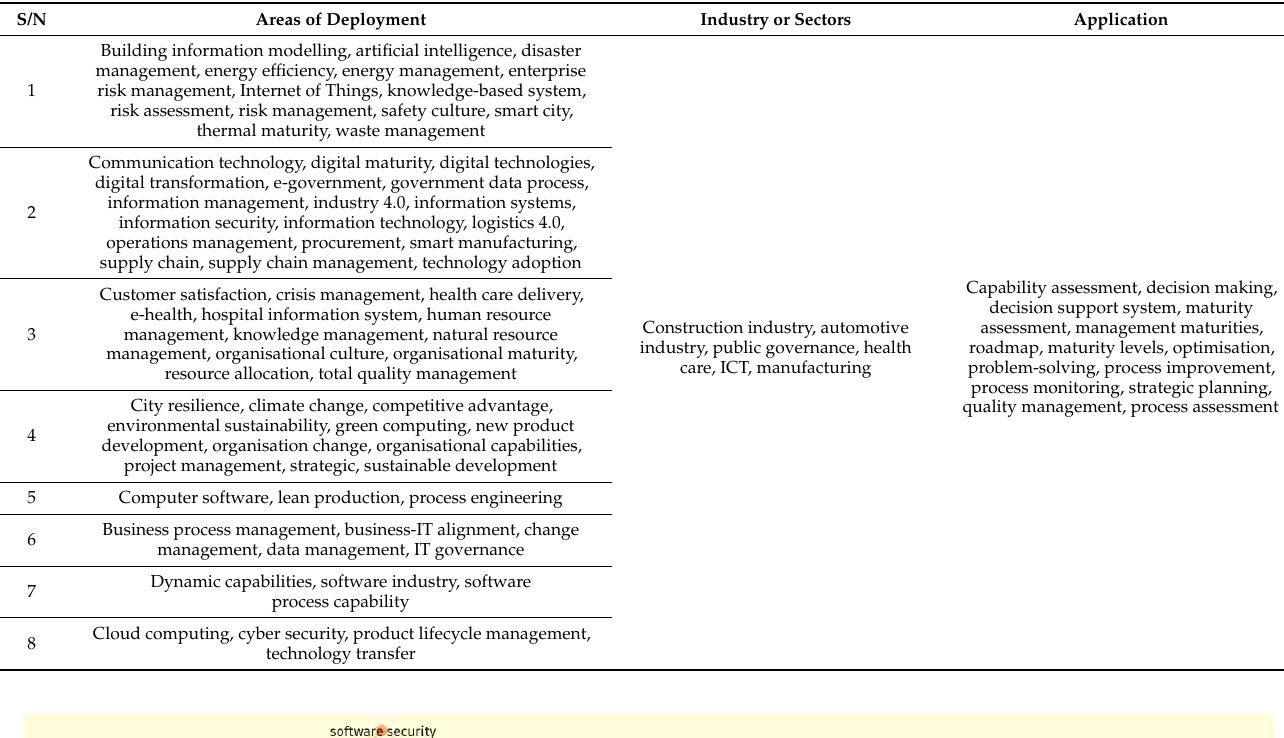
Table 2. Application of maturity model.